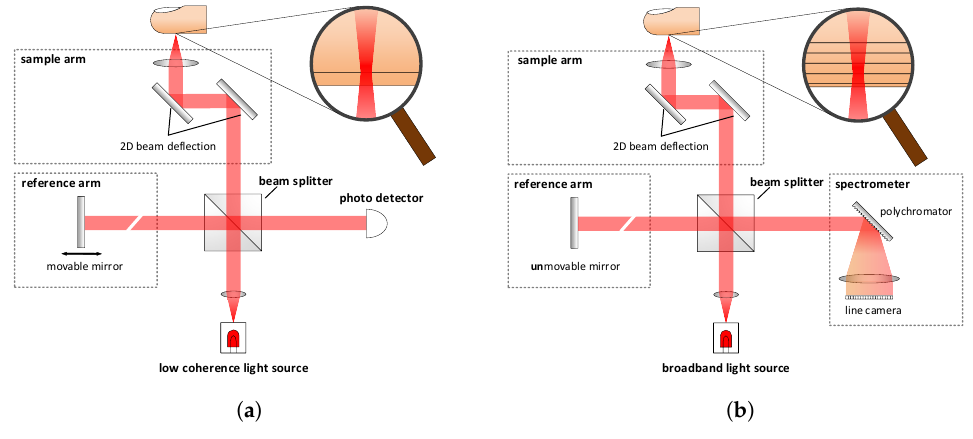
Figure 1. Basic OCT setup. ( a ) Time domain. ( b ) Spectral